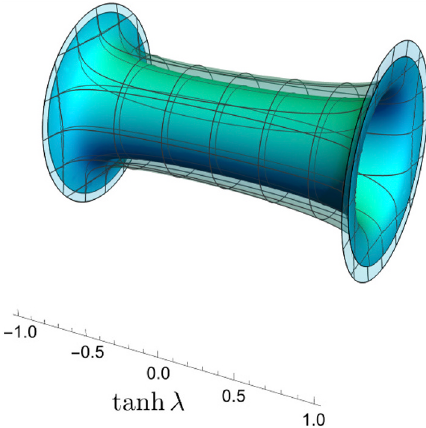
Figure 5 . Wormhole obtained from the construction in (cid:12)gure 4 in the case x wormhole is the inner solid surface, and the wormhole with dust is the outer translucent